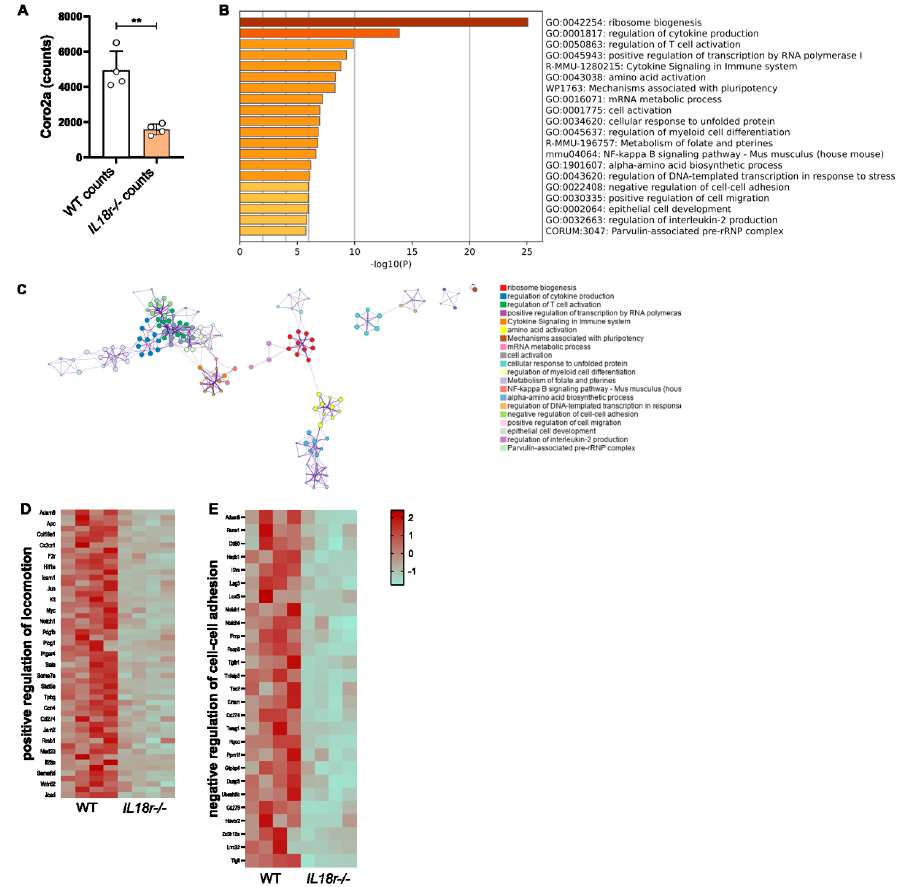
Figure 5. IL-18R signaling alters the transcription profile of motility-associated genes expressed in intratumoral CTLs. ( A ) RNA-Seq data were analyzed for the differential expression of genes that were ranked according to padj values. Coro2A expression ranked 7th among all genes with differ- ential expression. ( B ) The histogram of clustered enriched terms across input gene lists, color-coded on the basis of p -values. ( C ) Network of enriched terms; each color represents a distinct cluster ID. Nodes standing close to each other share the same cluster ID. ( D , E ) Heatmaps representing the Z- score visualization of the RNA-Seq results for ( D ) the positive regulation of locomotion and ( E ) negative regulation of cell–cell adhesion. Protein-coding genes that show significantly differential expression in WT and Il18r − / − T cells are depicted.